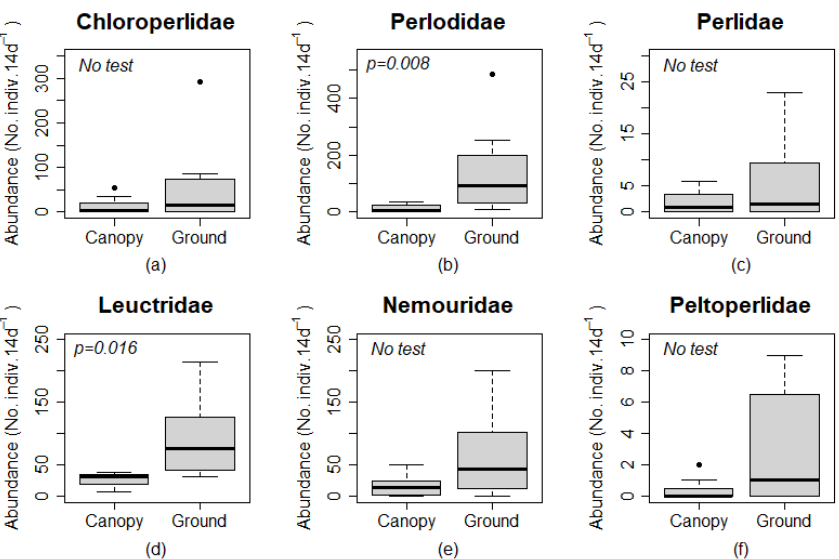
Figure 4. Box plots comparing abundances (No. individuals per 14 day period) of plecopteran fam- ilies ( a – f ) among canopy and ground traps. Box plots include zero data, and statistical significance are only shown for taxa without paired zero abundances among trap types. Boxes represent upper and lower quartiles, and whiskers extend to values no greater than or less than 1.5 times the inter- quartile range of the upper and lower quartiles, respectively. Points (•) are outliers outside the val- ues of the whiskers. Statistical comparisons were performed using a Wilcoxon sign rank test.